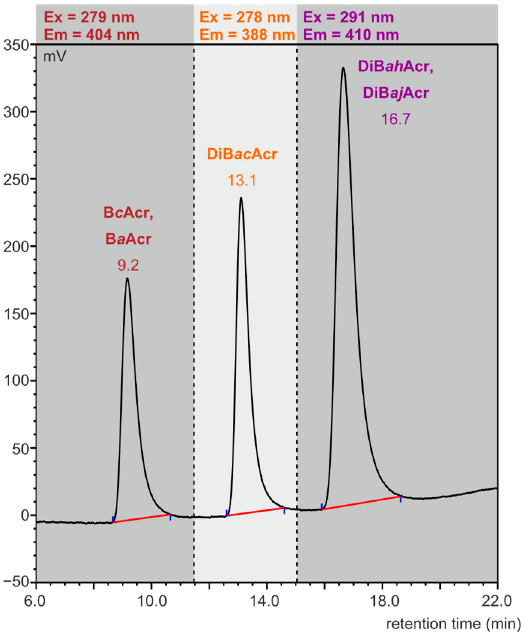
Figure 2. HPLC-FLD chromatogram of azaarene standard mixture (concentration: 0.1 ng/ µ L, injec- tion: 2.5 µ L).